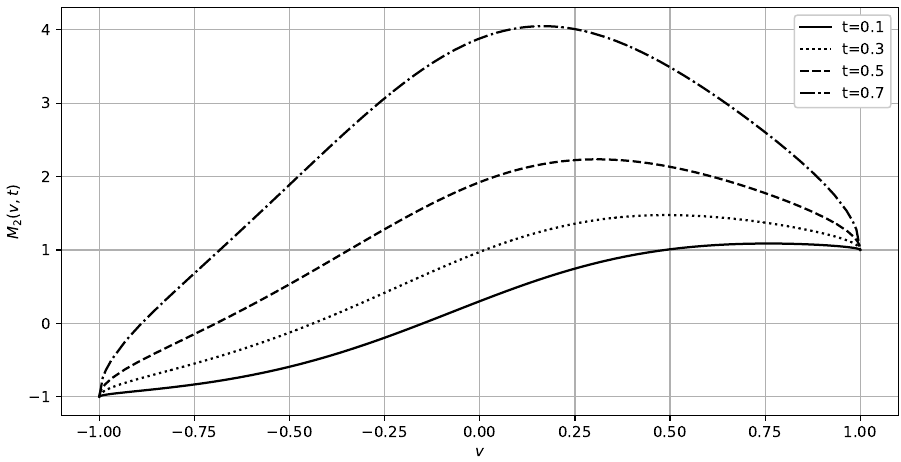
Figure 8. Plots of the function M 2 ( · , t ) for some t